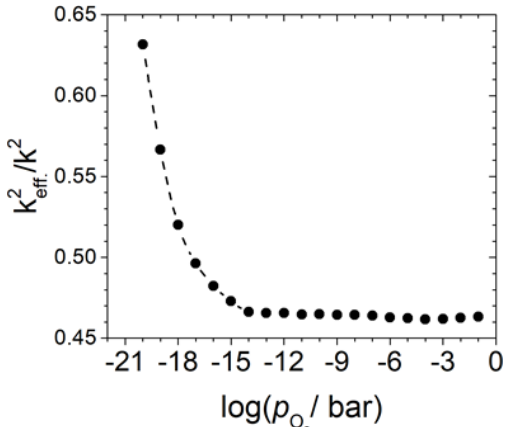
Figure 8. Change in the effective electromechanical coupling coef- ficient k 2 in dependence of the oxygen partial pressure p O eff 5MHz langasite resonator coated with a TiO 2 sensor film and op- erated in conductivity mode at 600 ◦ C. Calculated from the ratio of the capacities C m and C B and data from Fritze et al.